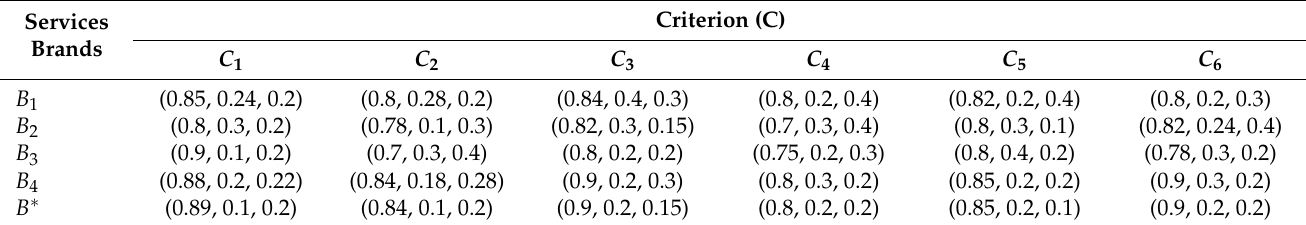
Table 5. Single-valued neutrosophic decision matrix (SVNDM).